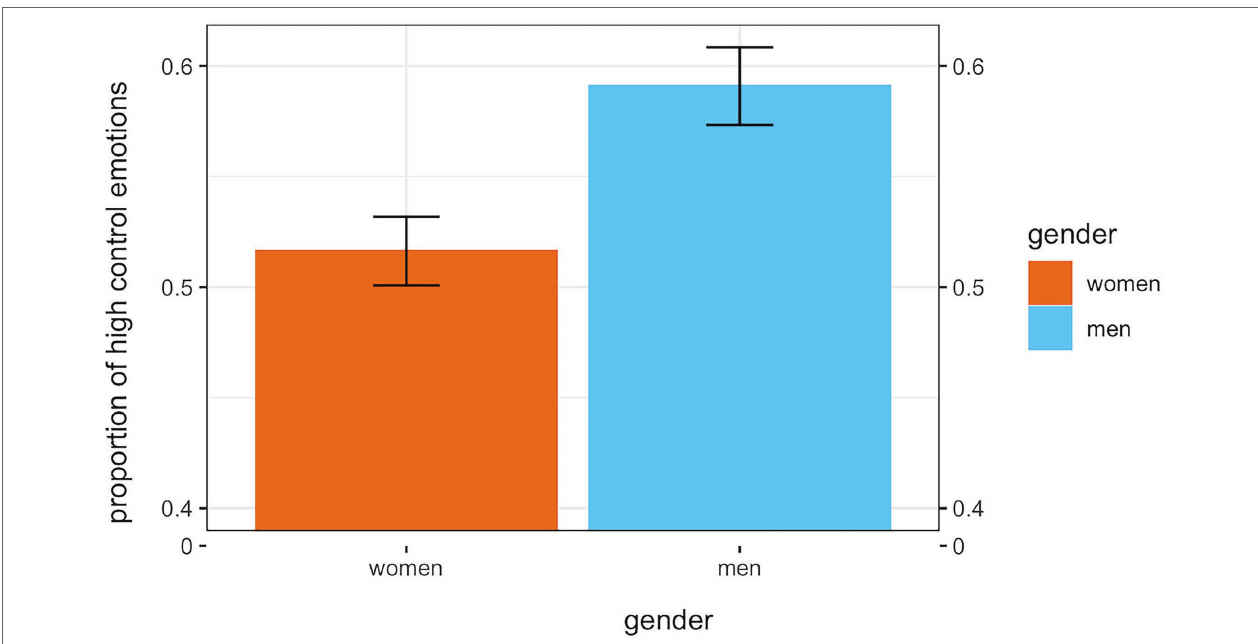
FIGURE 3 | Mean gender difference in proportion of high control-oriented emotions (study